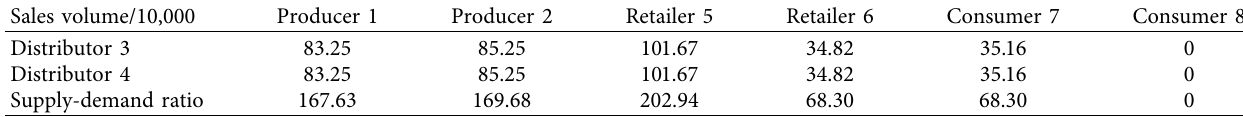
Table 1: Green product sales volumes in the GSCDN.